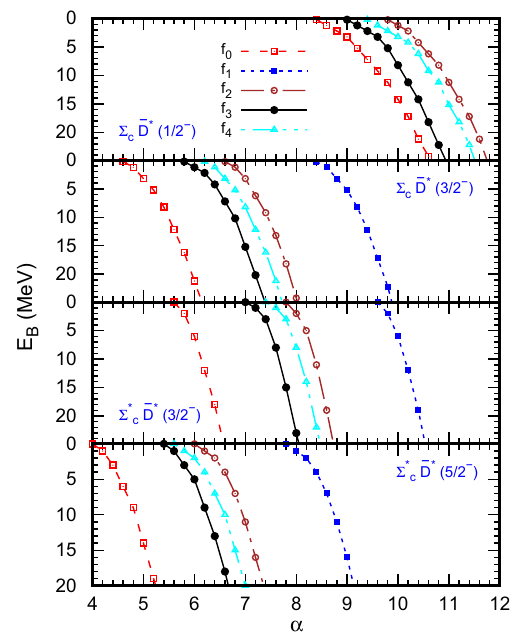
Fig. 2 The bindingenergy E B withthevariationofthe α forisoquartet bound states. The other conventions are the same as in Fig.